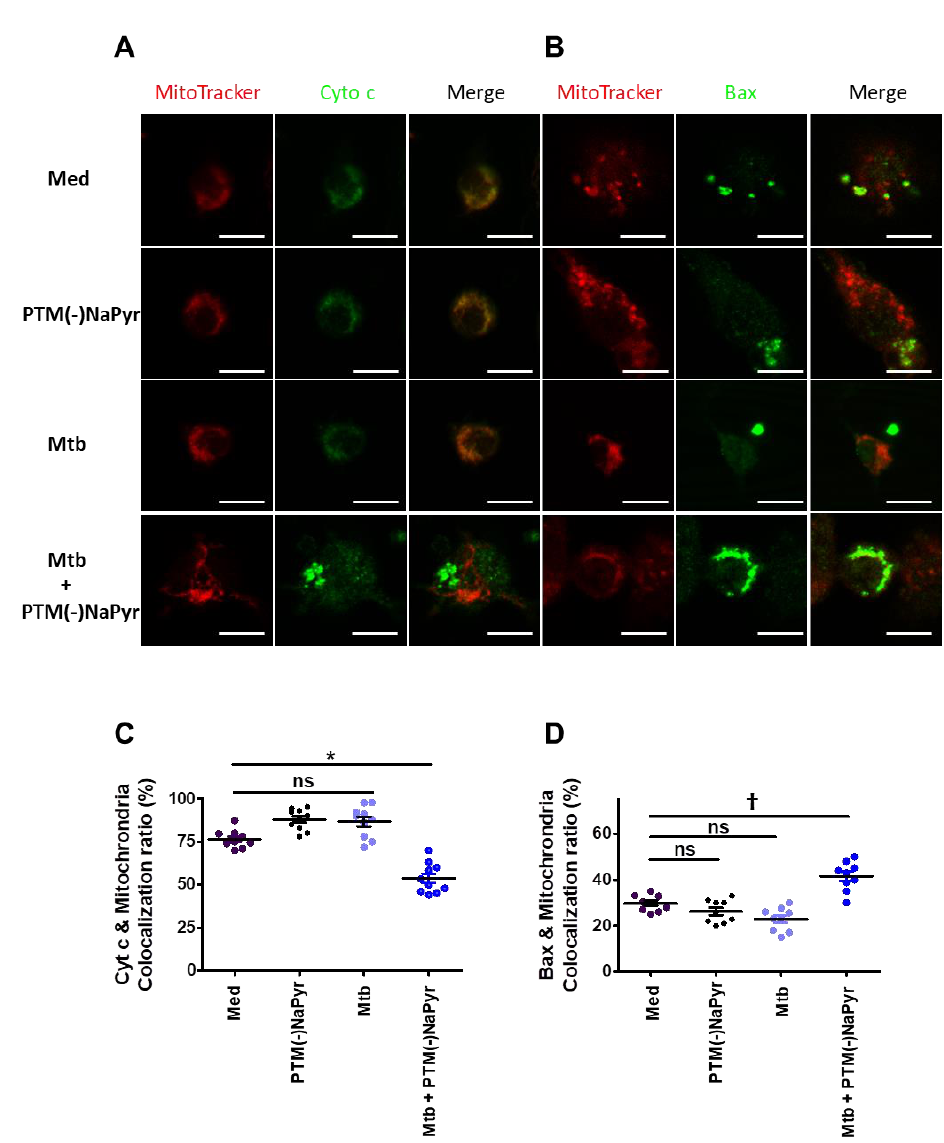
Figure 8. Changes in Cyt c and Bax localization in Mtb -infected cells incubated in PTM. ( A , B ) Repre- sentative confocal microscopy images show MitoTracker (red) and Cyt c or Bax (green) staining of cells incubated only in medium (Med), uninfected BMDMs incubated in PTM without NaPyr, cells infected with Mtb , and Mtb -infected cells incubated in 8-fold-diluted PTM without NaPyr for 18 h. ( A ) Cyt c, ( B ) Bax. Scale bar = 10 µ m. ( C , D ) Quantitative co-localization of Cyt c and Bax expressed as mitochondria (n) per cell. * p < 0.05 and † p < 0.01; ns: not significant; n =